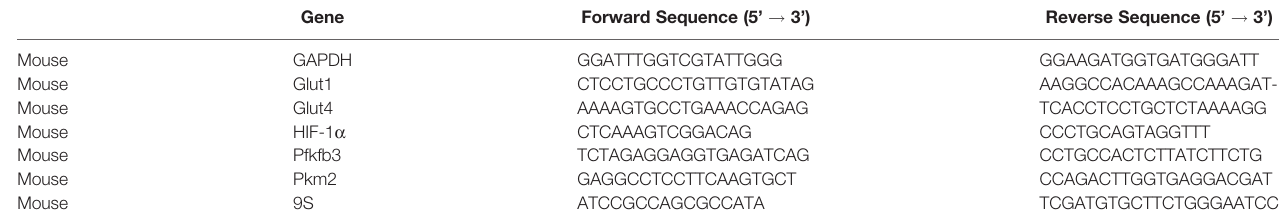
TABLE 1 | Primer sequences to measure mRNA levels using qRT-PCR.